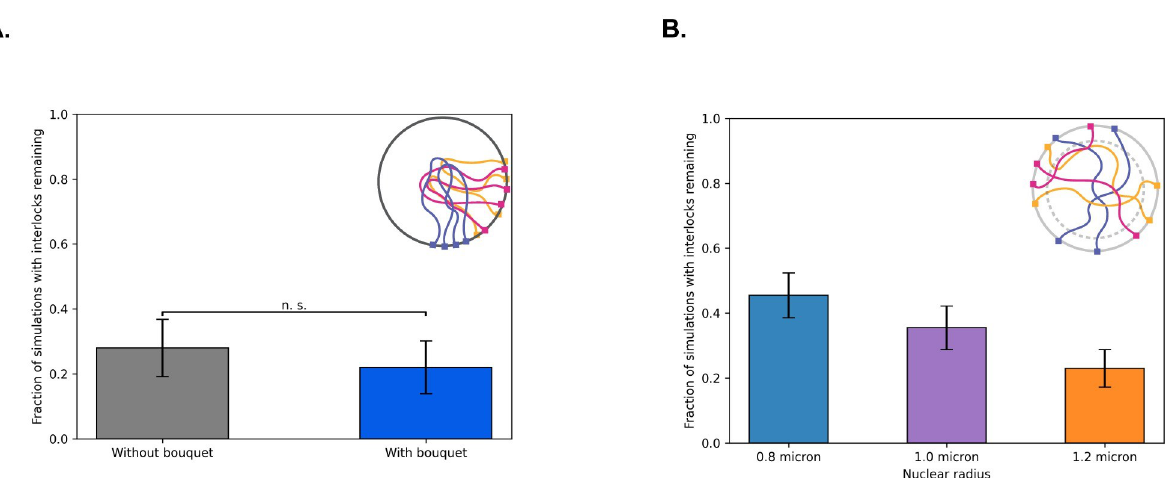
Fig 8. Effect of bouquet and nuclear volume increase on interlocks. (a) Percent of simulations with interlocks remaining in the presence and absence of a meiotic bouquet shows that the number of interlocks does not change significantly in the presence of a bouquet. (b) Percent of simulations with interlocks remaining at three different nuclear radii shows that increasing the nuclear volume decreases the number of cells with interlocks. Error bars indicate 95% confidence